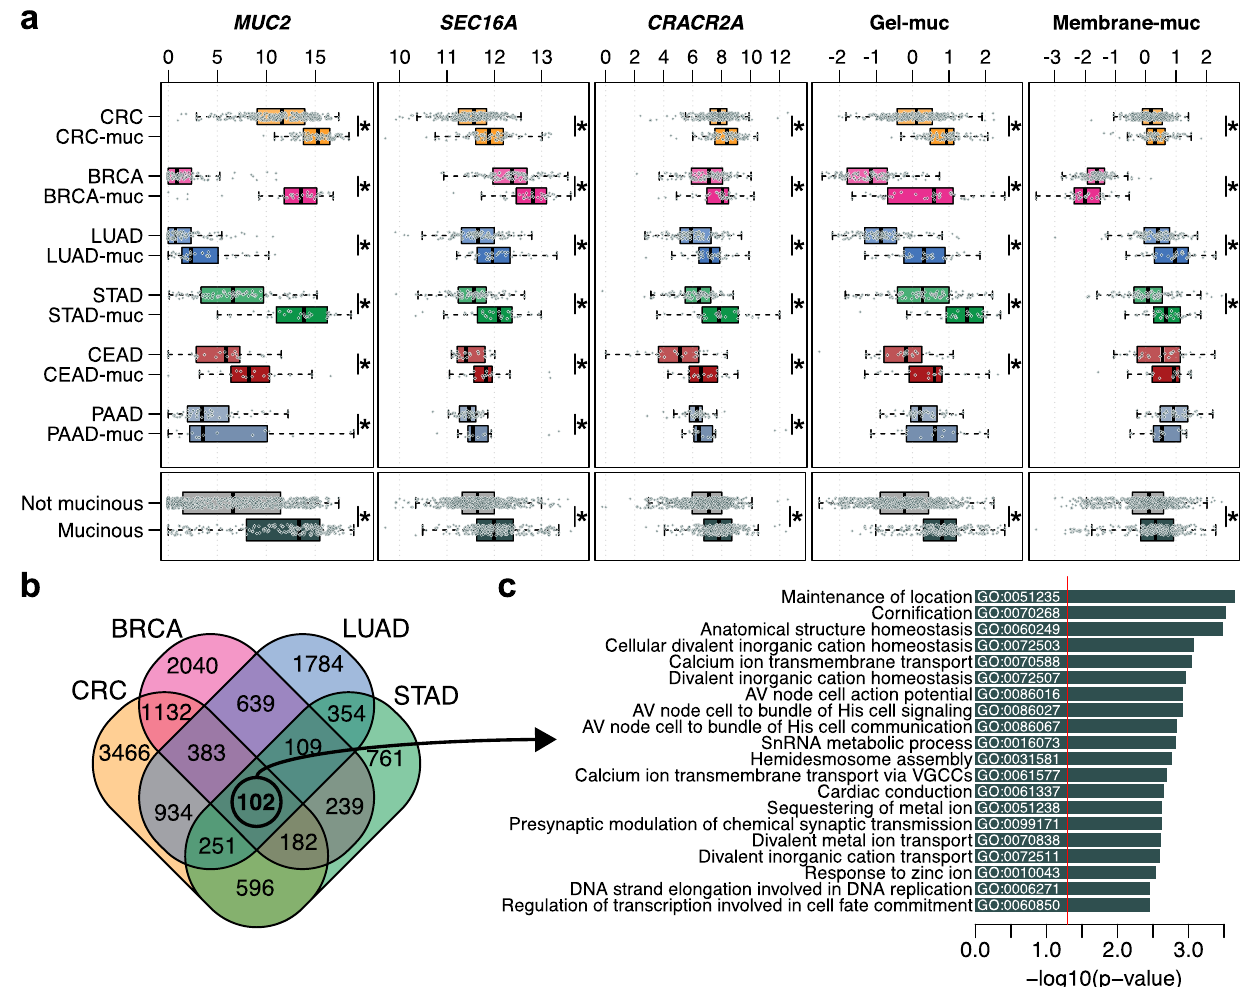
Figure 1. Transcriptomic similarities across carcinomas with mucinous differentiation from different cancer types. ( a ) Comparison of MUC2, SEC16A, CRACR2A, the gel-forming mucins signature (Gel-muc) and the membrane-bound mucins signature (Membrane-muc) between carcinomas-muc and controls for each cancer type (*; FDR < 0.05). Statistical significance was measured using the pairwise Mann–Whitney U tests adjusted for multiple comparisons. ( b ) Number of shared and unique differentially expressed genes between carcinoma-muc and control across each cancer type. ( c ) Top 20 enriched gene ontology terms associated with the 102 common differentially expressed genes. CRC colorectal adenocarcinoma, CRC-muc colorectal mucinous adenocarcinoma, BRCA infiltrating ductal carcinoma breast cancer, BRCA-muc mucinous carcinomas of the breast, LUAD lung adenocarcinoma, LUAD-muc mucinous (colloid) adenocarcinoma of the lung, STAD stomach adenocarcinoma, STAD-muc mucinous adenocarcinoma of the stomach, CEAD endocervical adenocarcinoma, CEAD-muc mucinous adenocarcinoma of endocervical type, PAAD pancreas- adenocarcinoma ductal type, PAAD-muc pancreas-colloid (mucinous non-cystic) quency of PIK3CA mutations in BRCA-muc (3/32 (9.4%) vs. 45/98 (45.9%), FDR = 0.006). Of note, we detected a lower frequency of TP53 mutation in BRCA-muc and PAAD-muc, a higher frequency of KRAS mutation in CRC-muc and LUAD-muc and a higher frequency of methylation silencing of TCF7 in CRC-muc and BRCA- muc and TCF7L2 and CDKN1B in BRCA-muc, although these observations did not reach statistical significance after correcting for multiple testing (Fig. 2c). Next, we compared the frequency of ten canonical oncogenic pathways commonly altered in cancer (RTK-RAS, p53, cell cycle, β-catenin/Wnt, PI-3-Kinase/Akt, Notch, TGFβ signaling, Myc, Hippo and Nrf2, as described in 15 ) in controls and carcinomas-muc. In CRC-muc, we observed a lower frequency of p53 pathway alteration and a higher frequency of TGFβ signaling and RTK-RAS path- ways alterations (19/48 (39.6%) vs. 153/189 (81%) FDR < 0.001, 28/48 (58.3%) vs. 35/189 (18.5%) FDR < 0.001, 43/48 (89.6%) vs. 140/189, FDR = 0.07). In BRCA-muc, we observed a lower frequency of PI-3-Kinase/Akt path- way alterations and a higher frequency of β-catenin/Wnt pathway alterations (8/32 (25%) vs. 58/98 (59.1%), P = 0.001, FDR = 0.01 and 11/32 (34.4%) vs. 13/98 (13.3%), P = 0.02, FDR = 0.08). In LUAD-muc, we observed a lower frequency of p53 and TGFβ signaling pathways alterations (8/35 (22.9%) vs. 63/101 (62.4%), P < 0.001, FDR < 0.001 and 0/35 (0%) vs. 12/101 (11.8%), P = 0.03, FDR = 0.18). Finally, in STAD-muc, we observed a lower